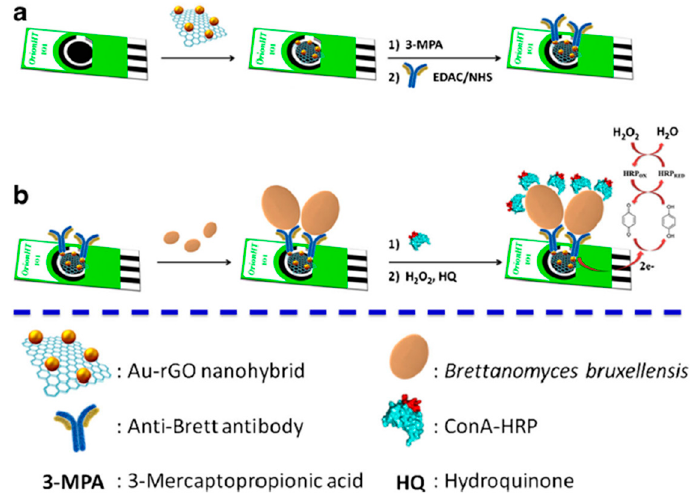
Figure 2. ( a , b ) Electrochemical immunosensor for Brettanomyces bruxellensis at a SPCE nanostructured with AuNPs-rGO and further modified with 3-MPA and enzymatic labelling with ConA-HRP. Reprinted and adapted from [75] with permission.